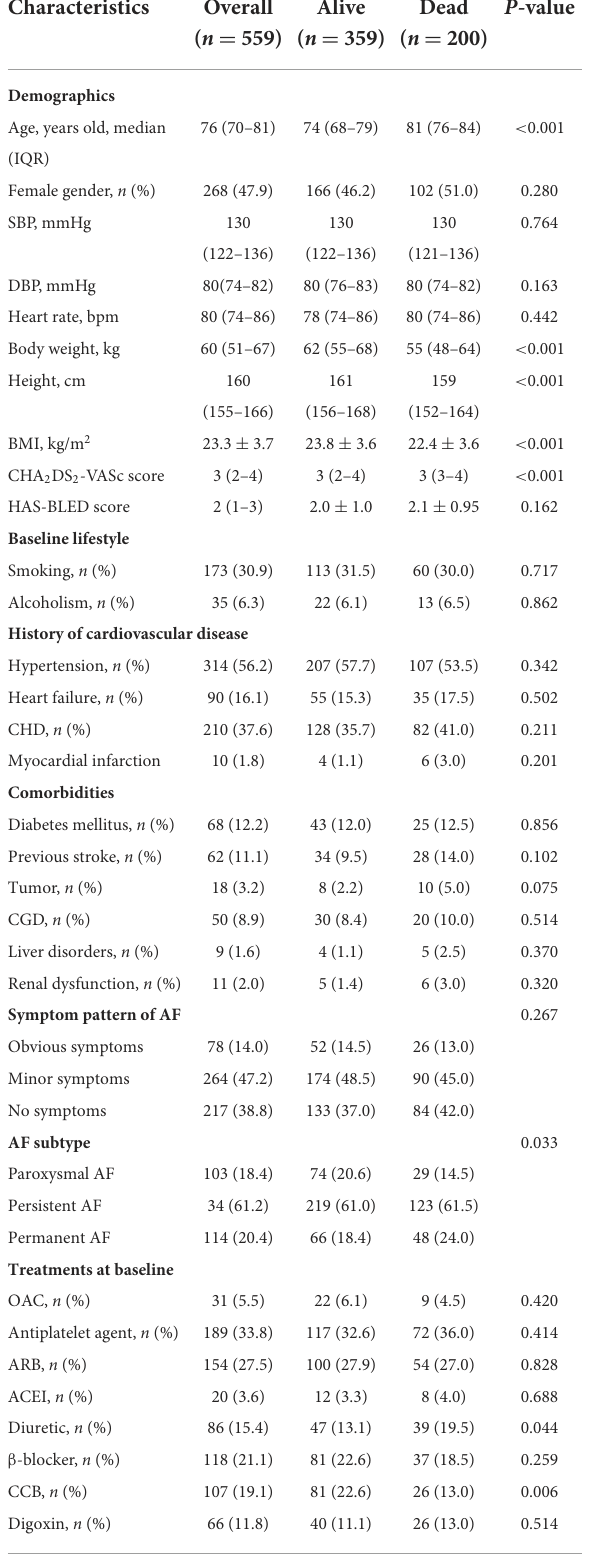
(Table 3). Meanwhile, age, diabetes mellitus, symptom pattern of AF, AF subtype, previous tumor, liver diseases were